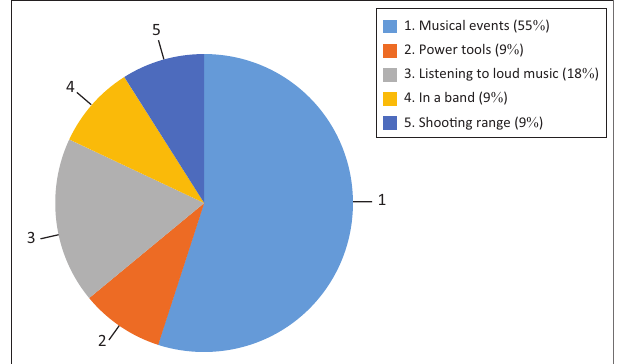
FIGURE 2: Recreational noise exposure.